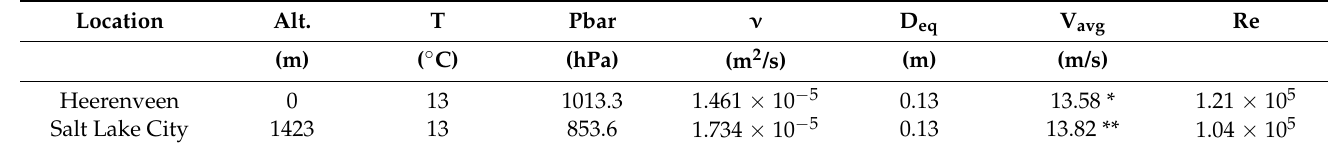
Table 6. The effect of altitude on the lower-leg average Reynolds number, men’s 5000 m. Location Alt.